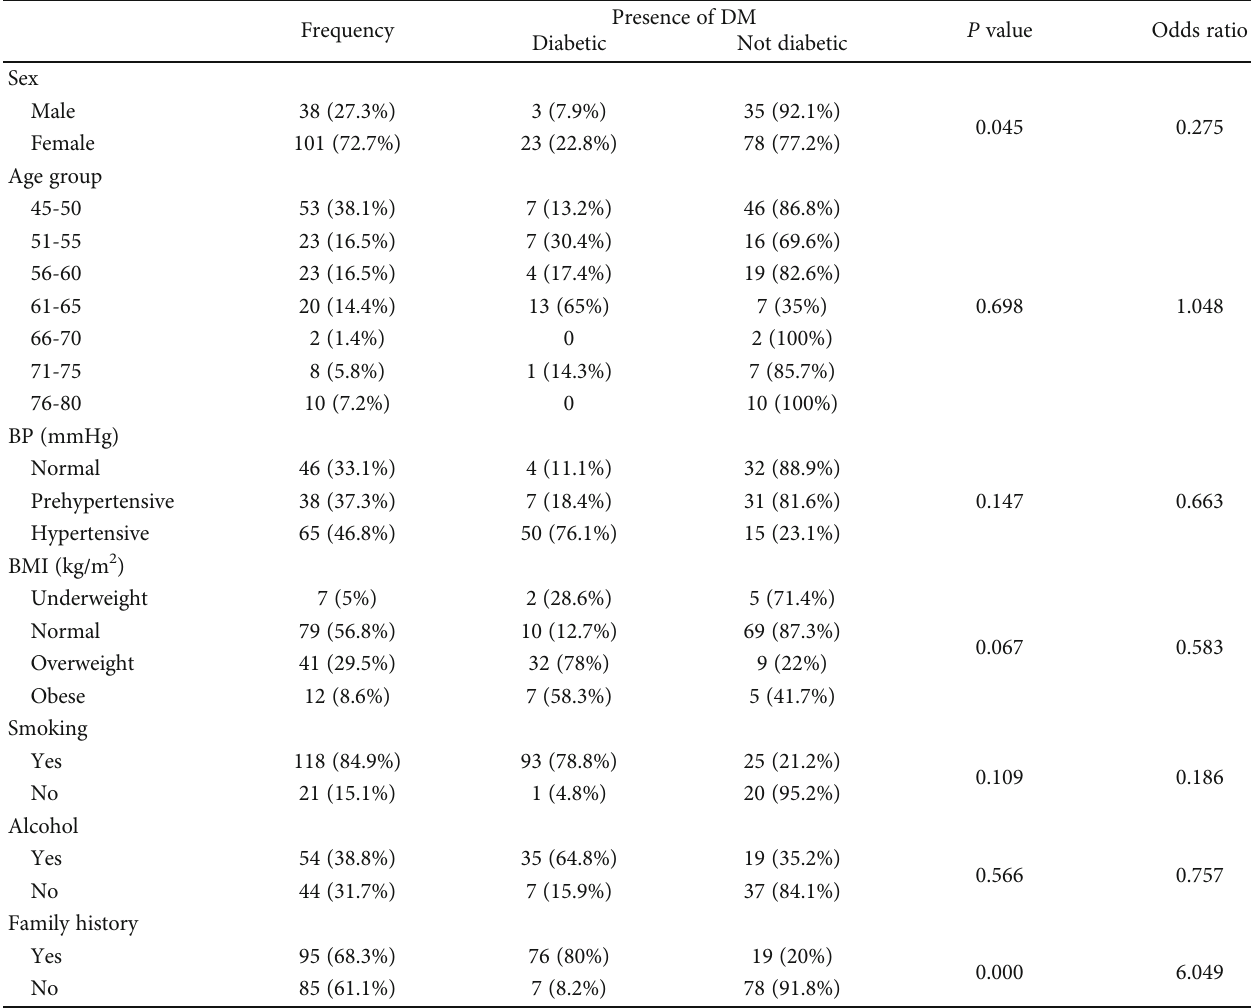
Table 1: Bivariate analysis of sex, age groups, and risk factors associated with type 2